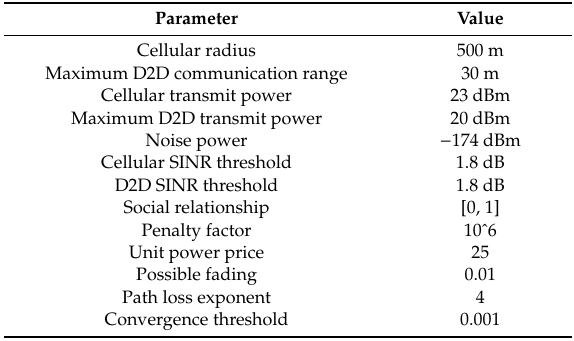
Table 1. Simulation